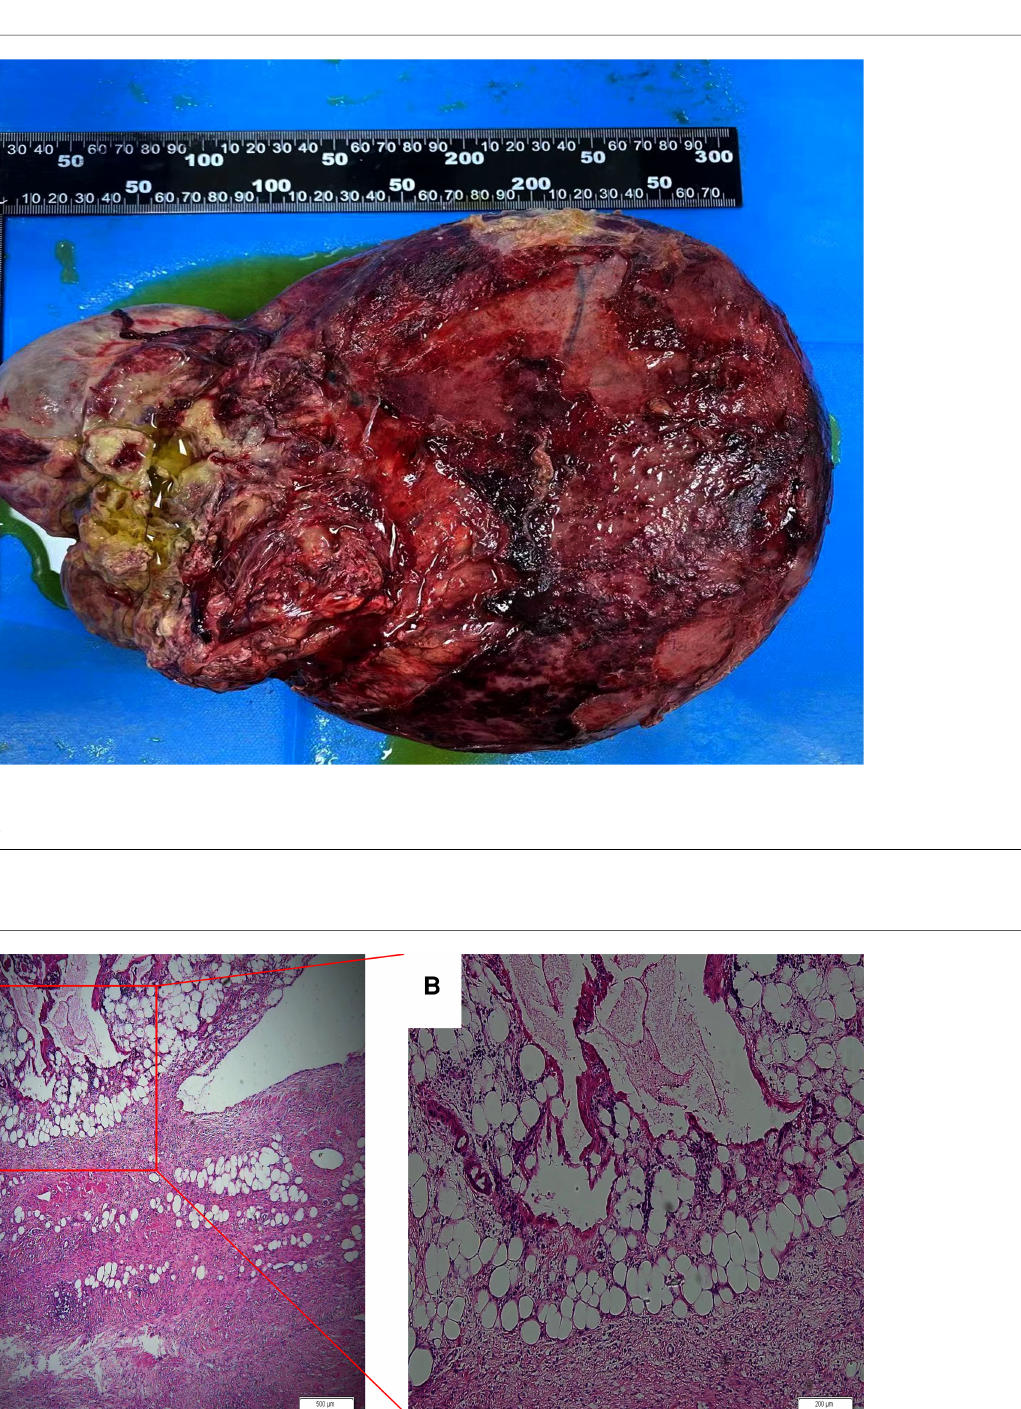
FIGURE 3 Necrosis and protein exudation in the cystic cavity, obvious proliferation of interstitial vessels and fi brous tissue, cystic lymphatic cavities of different sizes with in fl ammatory lymphocyte in fi ltration and lymphoid nodules; ( A ) hematoxylin and eosin (HE)×40, scale 500 μ m; ( B ) HE×100, scale 200 μ